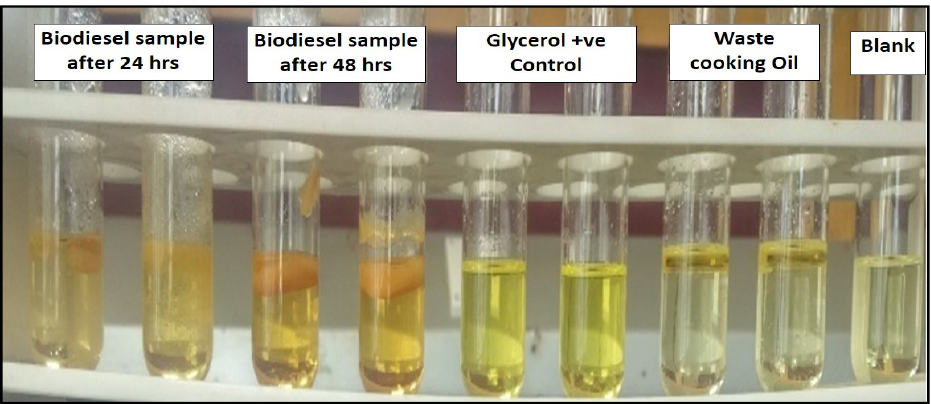
Figure 8. Qualitative analysis of biodiesel by glycerol assay.